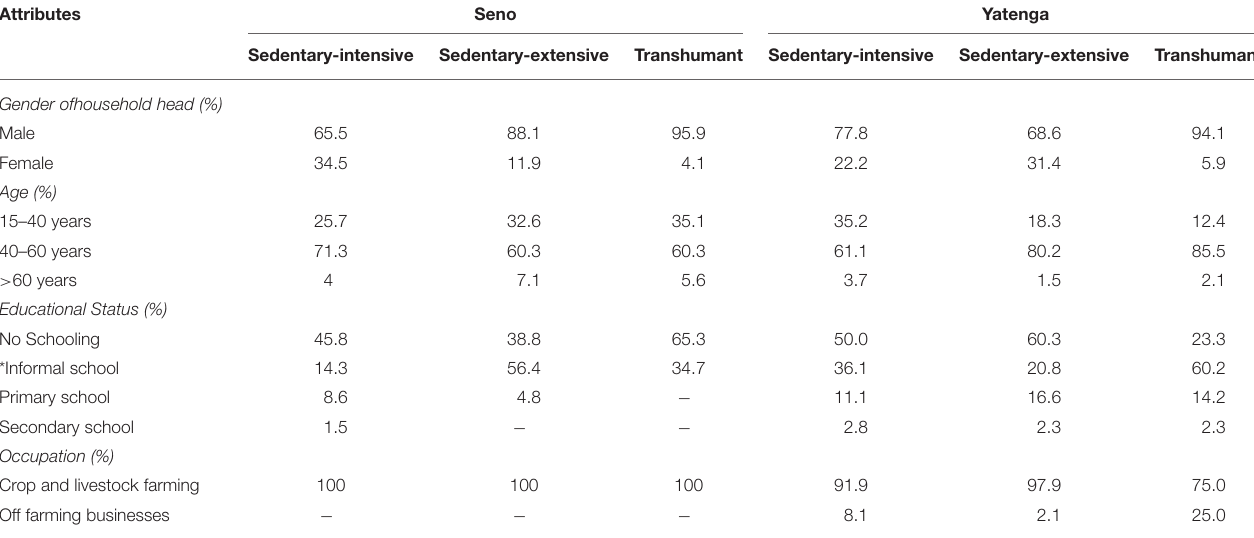
TABLE 1 | Household demographic and socio-economic profile of respondents across the study sites (in percentage). Attributes Seno Yatenga Sedentary-intensive Sedentary-extensive Transhumant Sedentary-intensive Sedentary-extensive